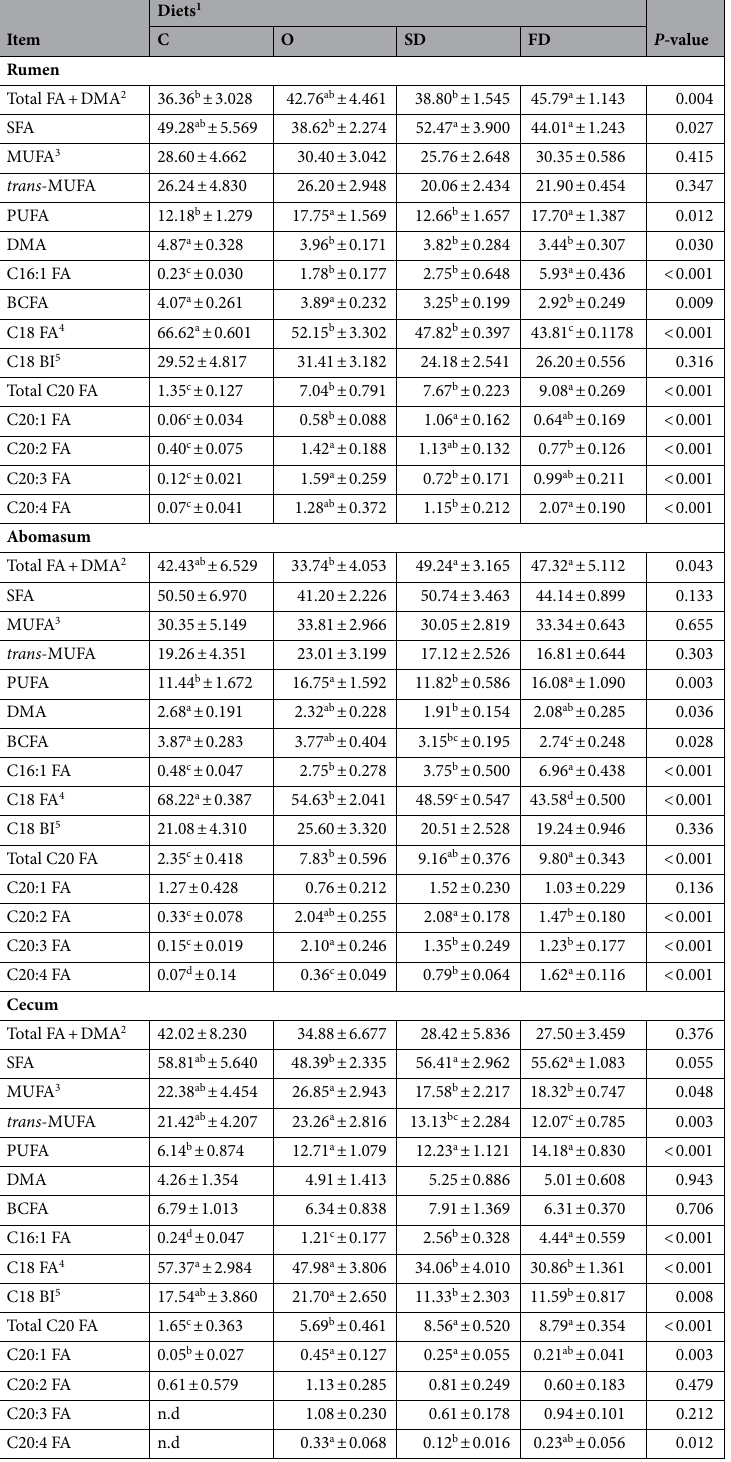
Table 1. Total FA and dimethyl acetals content (mg/g DM) and FA partial sums (% total FA + DMA) in the rumen, abomasum, and cecum. Values are means ± standard error of the mean. Means within a row with different letters are significantly different (P < 0.05). 1 Diets (or treatments): C, control; O, Control plus